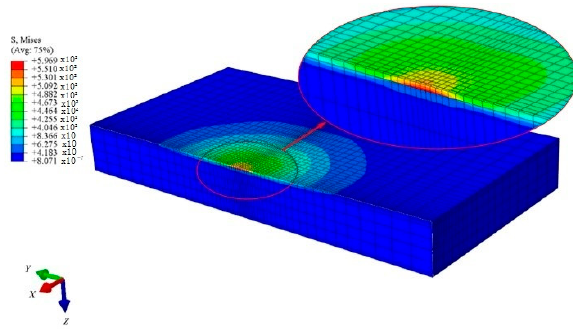
Figure 5. Stress nephogram of 100 kA multi-field coupling simulation along the thickness direction.